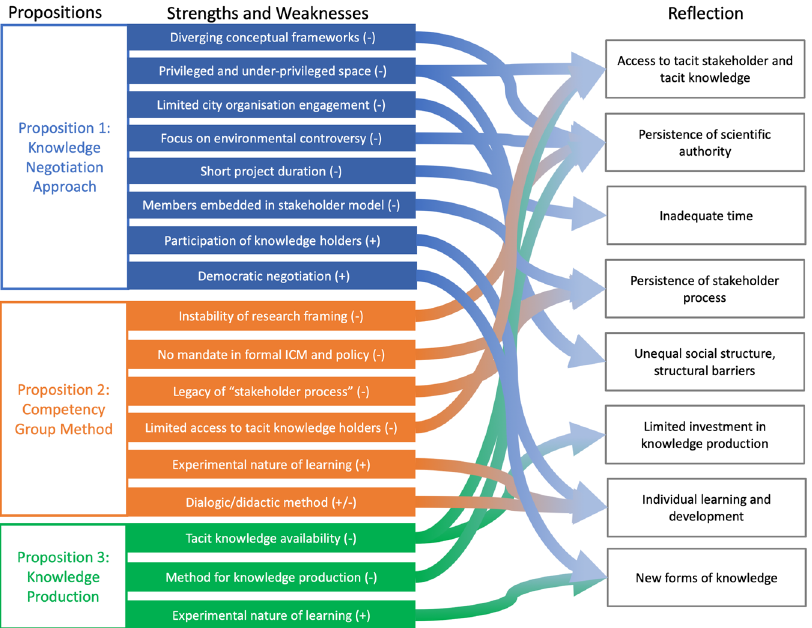
Fig. 2 Observations and re fl ections on the strengths ( + ) and weaknesses ( − ), ordered by the propositions of the study on the use of competency groups, as part of a transdisciplinary approach, to generate new knowledge for coastal